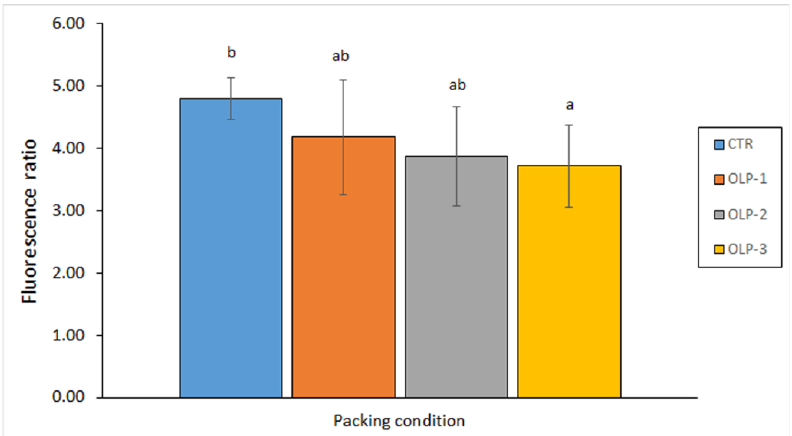
Figure 3. Determination of the fluorescence ratio in canned mackerel ( S. colias ) packed under different packing conditions. Different letters denote significant differences ( p < 0.05) as a result of the packing medium. Sample abbreviations: CTR (Control), and OLP-1, OLP-2 and OLP-3 (low-, medium- and high-concentrated octopus cooking liquor, respectively). Adapted from Malga et al. [95].